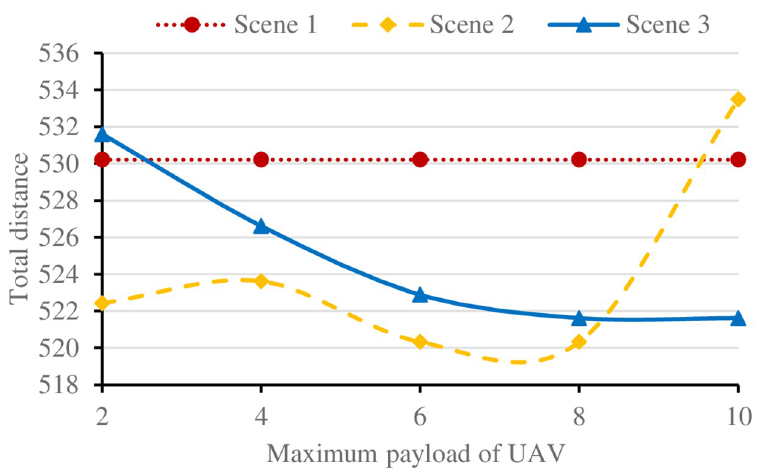
Fig 7. Results of three scenarios under different